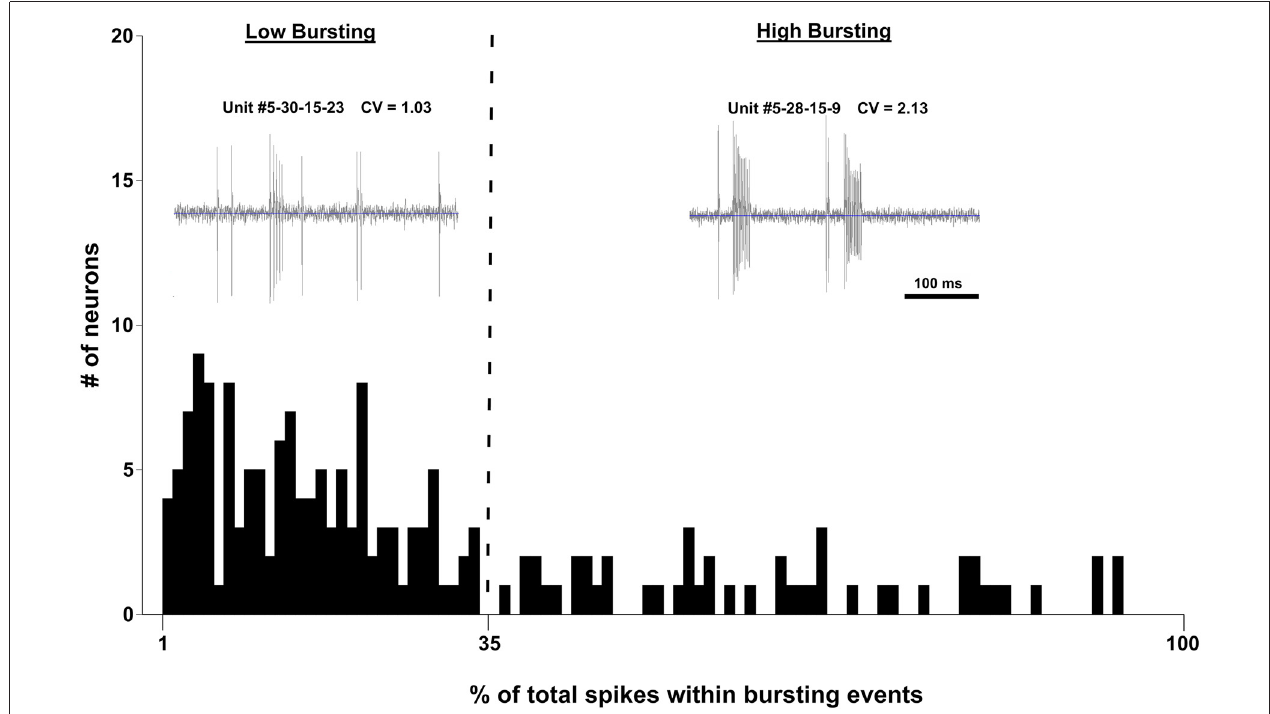
FIGURE 5 | Histogram of the percentage of spikes that occurred in bursting events of 502 IC neurons recorded from four control mice and four exposed mice . Units were separated into Low Bursting (LB) and High Bursting (HB) units using a 35% cutoff point (vertical dashed line) which was determined statistically. Examplar units for each bursting classification are shown in the upper part of the figure. Each unit includes its coefficient of varation (CV) which represents a measure of spike regularity. Higher CV values mean that a given neuron is bursting